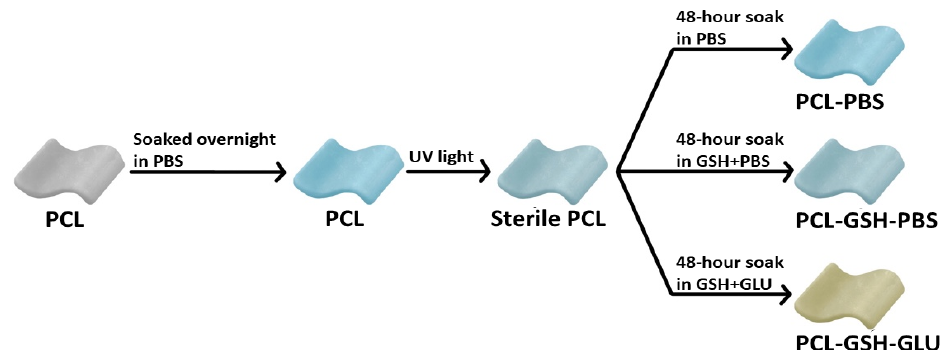
Figure 3. Schematic representation of study sample preparation.